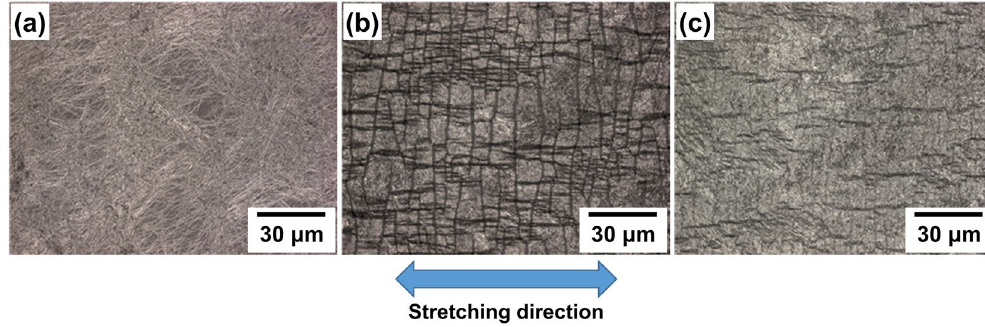
Figure 3. AgNWs deposited on a hydroxylated PDMS film, ( a ) the pristine state, ( b ) under stretching with 100% strain and ( c ) after release.